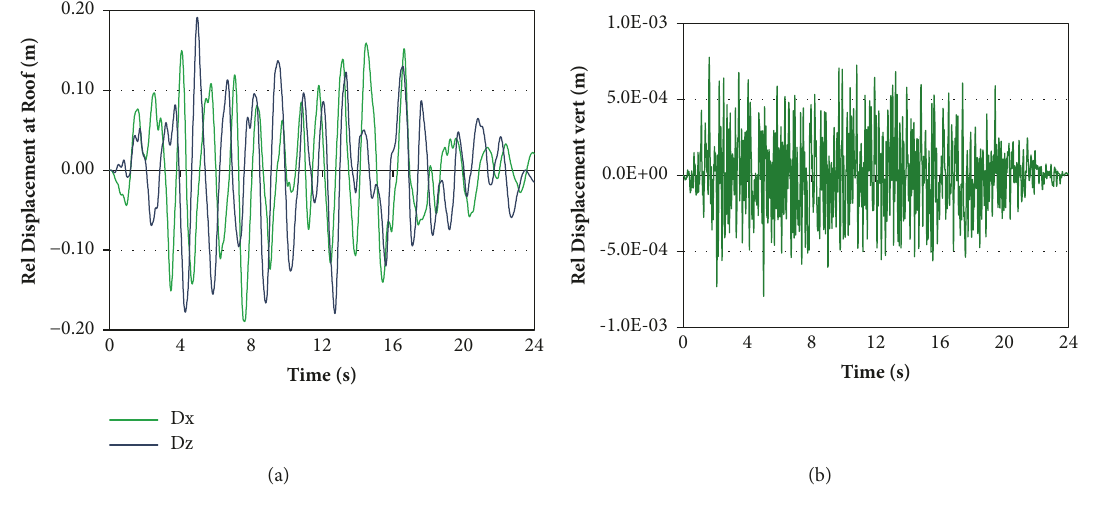
Figure 11: Relative displacements behaviour at roof